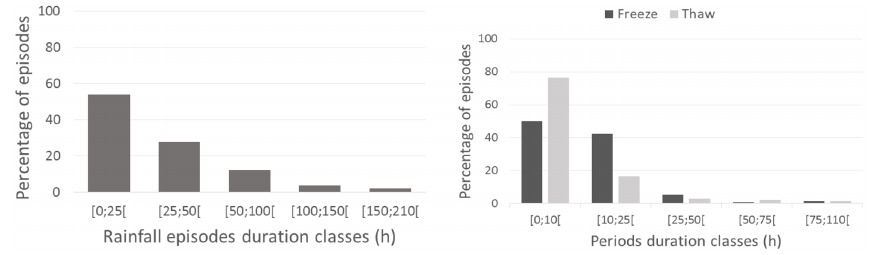
Figure 4. Distribution of rainfall episodes duration, and of freezing and thawing periods duration. More than 80% of thawing episodes are shorter than 12h, and almost 95% of thawing periods are shorter than 24h. Long thawing periods occurred only at the end of the winter, when freezing no longer occurs.